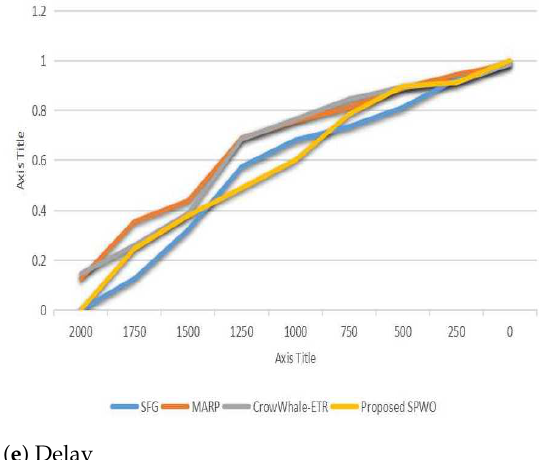
Figure 6. Analysis using 150 nodes.